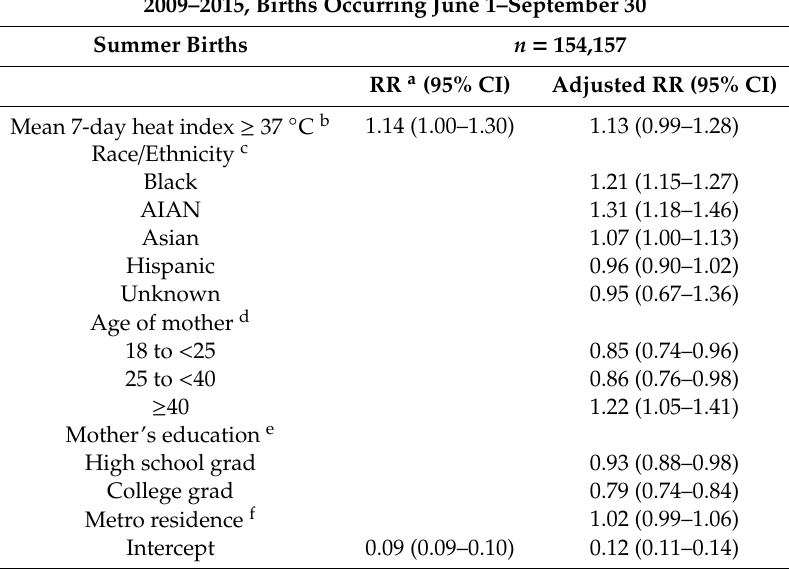
Table 2. Association of seven-day mean high heat greater than 37 ◦ C with PTB for live births to women in Minnesota from 2009 to 2015, with results for main exposure, and main exposure plus race / ethnicity, mother’s age, metro residence, and mother’s education. All models adjusted for year of birth (fixed e ff ect) and all other